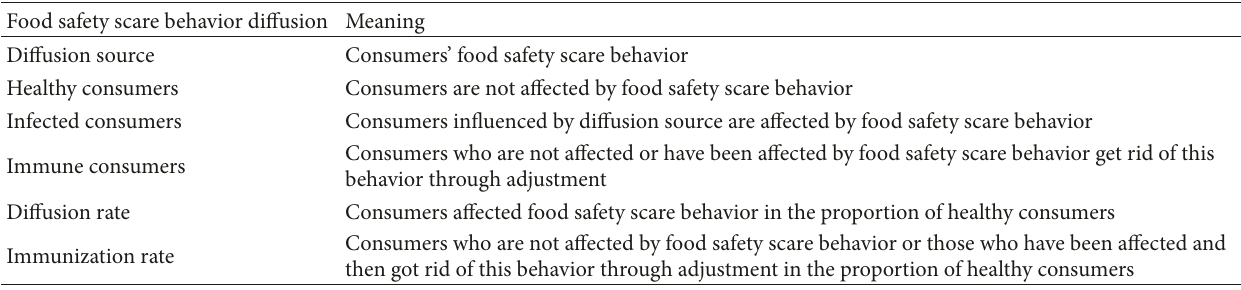
Figure 1: Diffusion medium and diffusion path of food safety scare behavior. Table 1: Corresponding concept of food safety scare behavior